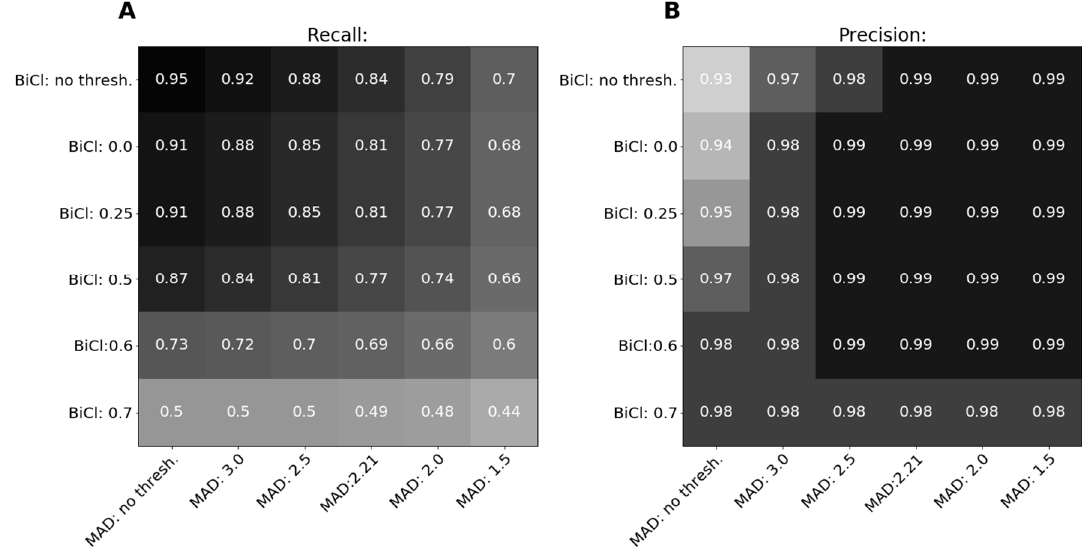
Figure 9. Evaluation of gold standard (EN–FR) for various BiCleaner and MAD thresholds. The first row shows recall/precision when no threshold was set for BiCleaner, the first column shows recall/precision when no threshold was set for MAD. ( A ) Recall. ( B ) Precision.